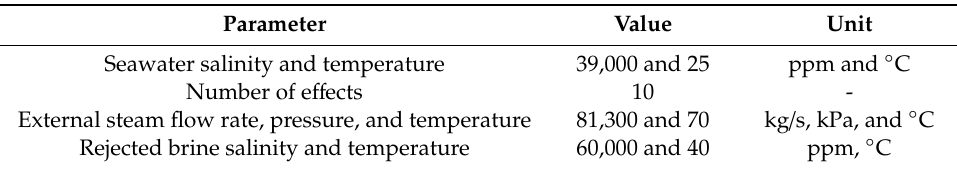
Table 1. Specifications of feed seawater and the multi e ff ect distillation / thermal vapour compression (MED_TVC) process (adapted from